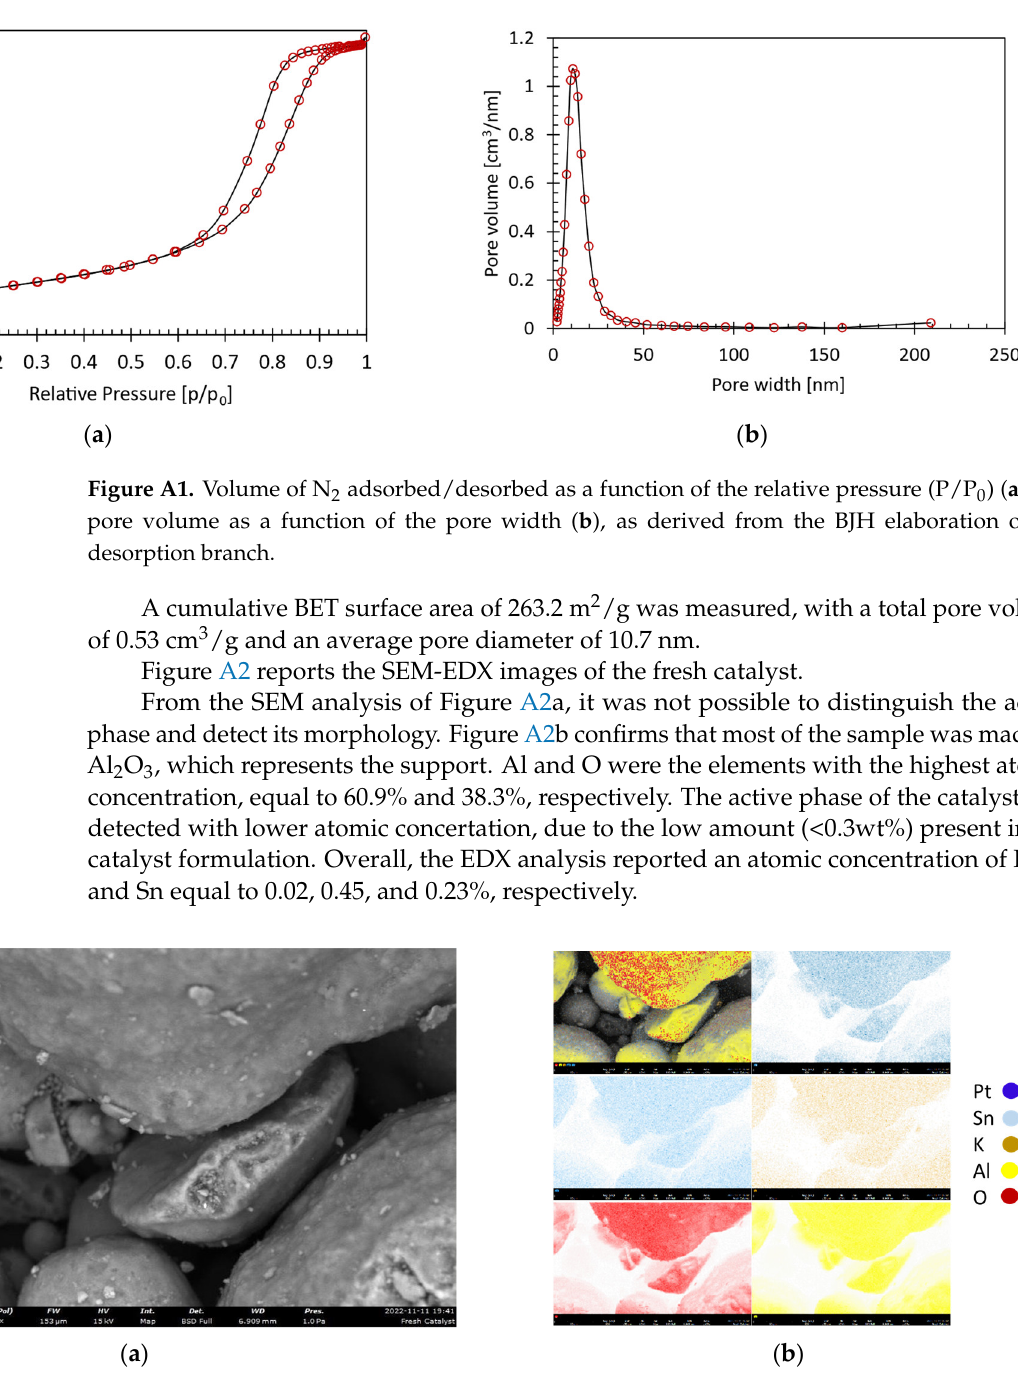
Figure A2. SEM ( a ) and EDX ( b ) images of the fresh PtSnK/Al 2 O 3 catalyst used in this work.